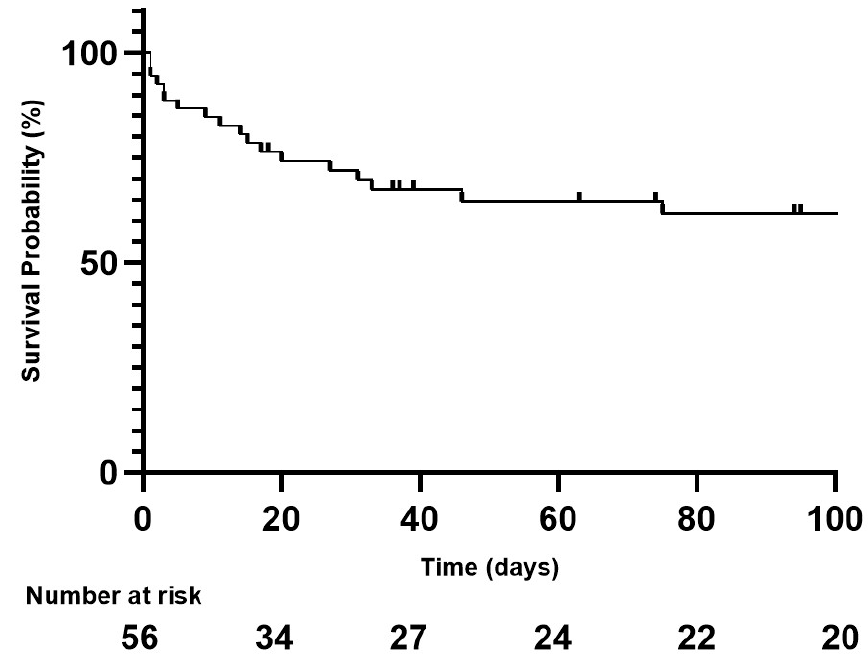
Figure 4. Kaplan–Meier curve of overall survival during the first 100 days following TAE. Univariate and multivariate analyses are detailed in Table 5. There was no association Table 4. Patient outcomes. between early death and age, sex, performance status, target artery, or the use of coils. Table 5. Univariate and multivariate regression analysis for early